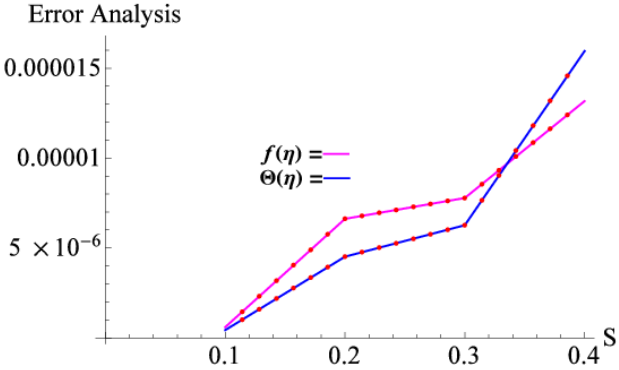
Figure 6. Parameter range of the common unsteady parameter S . The influence of the slide factor γ on F (cid:48) ( η ) velocity distribution is illustrated in Figure 3a for the hybrid nano liquid ( Cu + Al 2 O 3 / H 2 O ) and the nano liquid ( Cu / H 2 O ). The figures indicate that the velocity profile F (cid:48) ( η ) declines by improving the sliding factor, but on the other hand, the temperature profiles show the opposite tendency. It is because a reduction in surface friction between the stretched sheet and liquid occurs as the sliding factor increases. The thickness of the fluid layer also decreases as the slide pa- rameter increases. However, an increase in the sliding parameter generates the frictional force, which allows more liquid to slide past the sheet and the deceleration of the flow, and the temperature field is increased due to the action of force. Moreover, the maximum velocity is observed for hybrid nano liquid (